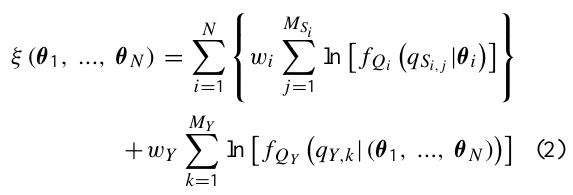
Fig. 1. Schematic representation of the upper Blue Nile Basin (hatched) within Blue Nile River basin (outlined). Source: Fig. 1 in Elshamy et al.